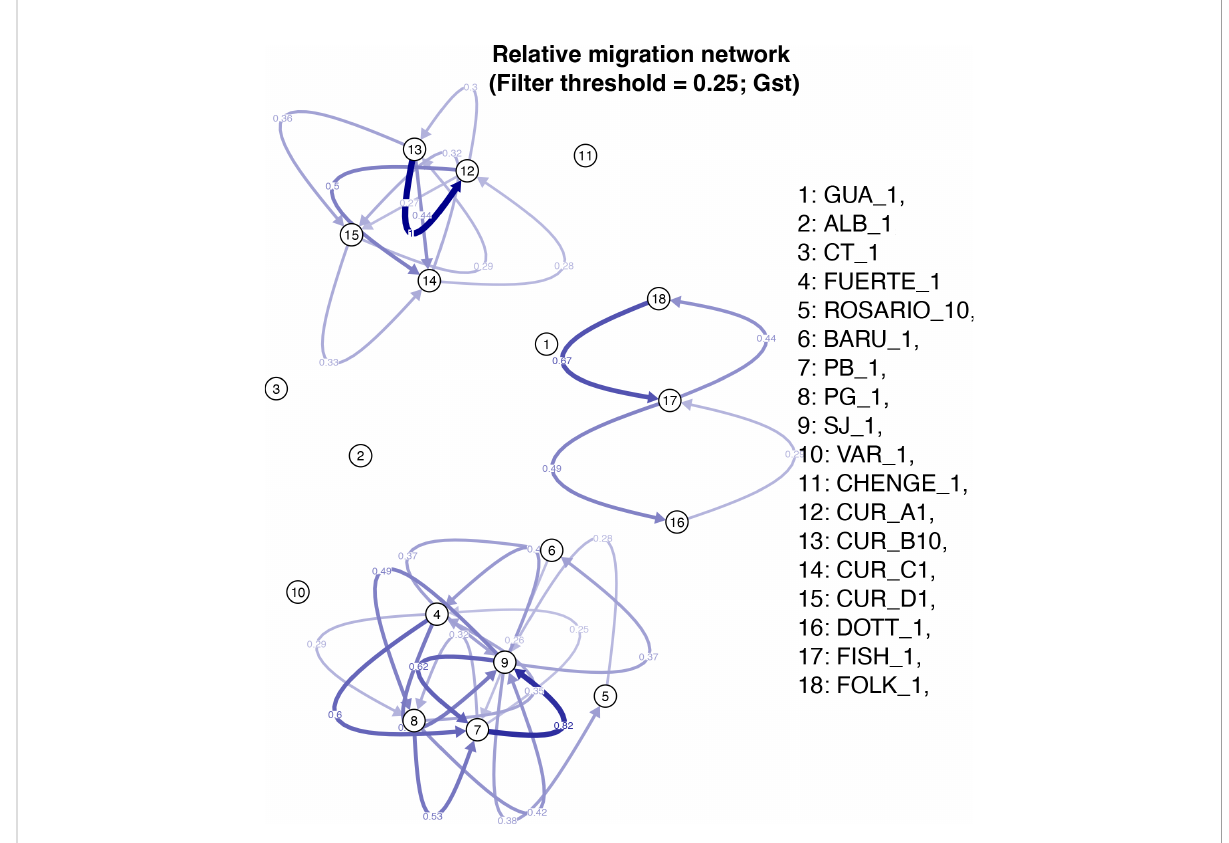
FIGURE 4 Relative migration among the different localities of M. auretenra in the Caribbean